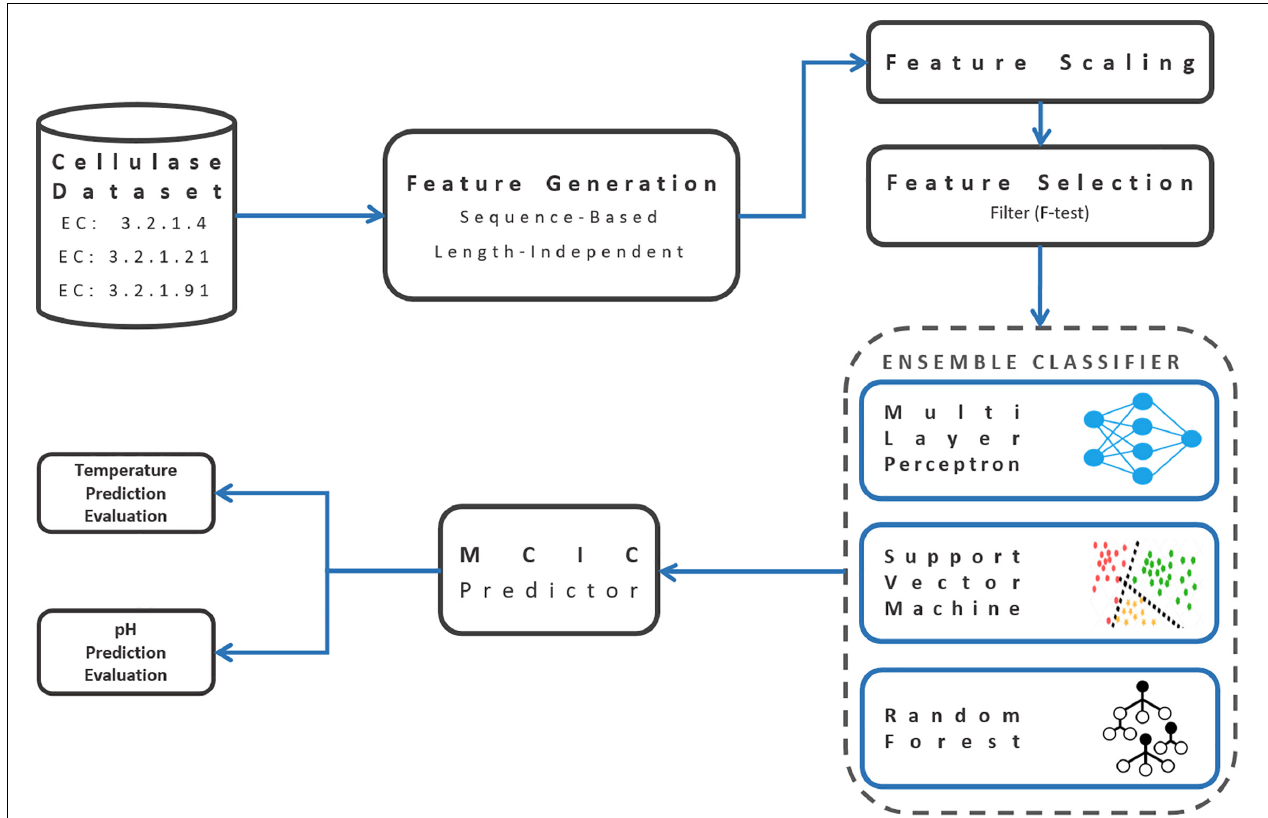
FIGURE 2 | Schematic workflow of building the MCIC’s prediction